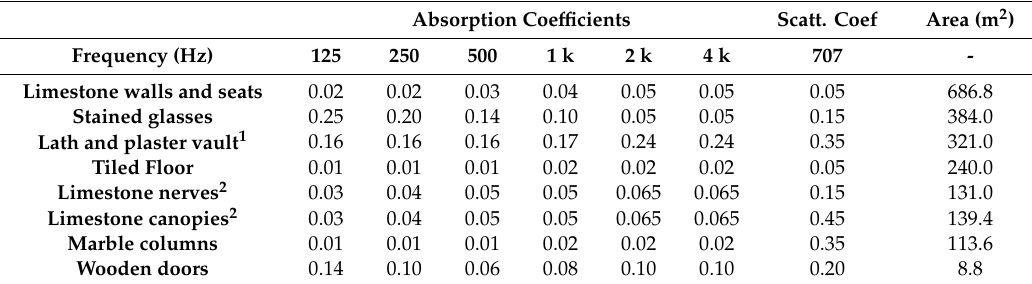
Table 3. Acoustic properties of the materials used in the simulation model of the York Minster’s Chapter House, and the area which each of them occupies in the